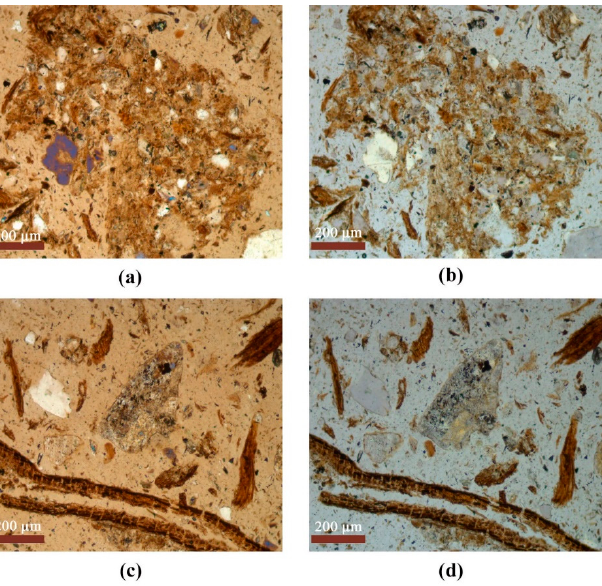
Figure 5. Organ residues of study soils (S 1 − 6). ( a , c ) Plane polarized light; ( b , d ) crossed polarized light.